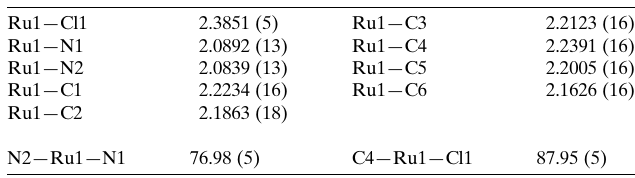
Table 2 Hydrogen-bond geometry (A˚ , (cid:5) ).